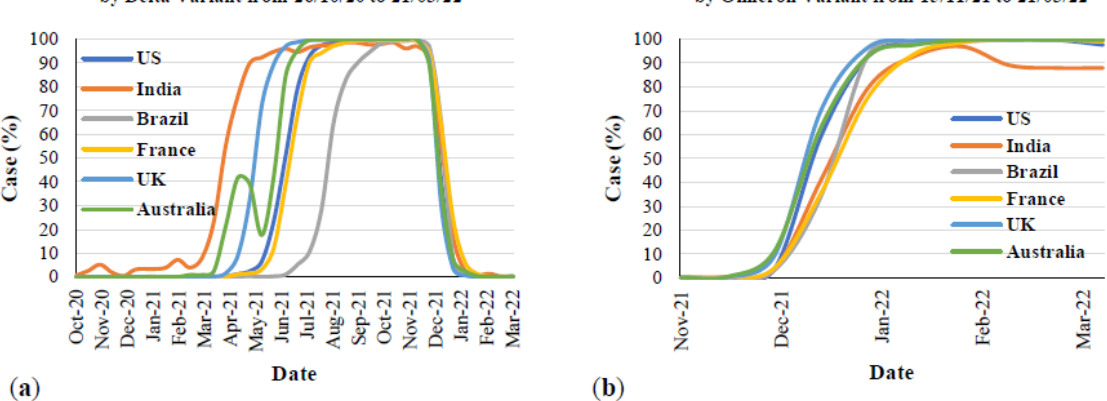
Figure 7. The timeline of SAR-CoV-2 cases in Australia and the most affected countries from 26 October 2020 to 21 March 2022: ( a ) Delta variant; ( b ) Omicron variant.